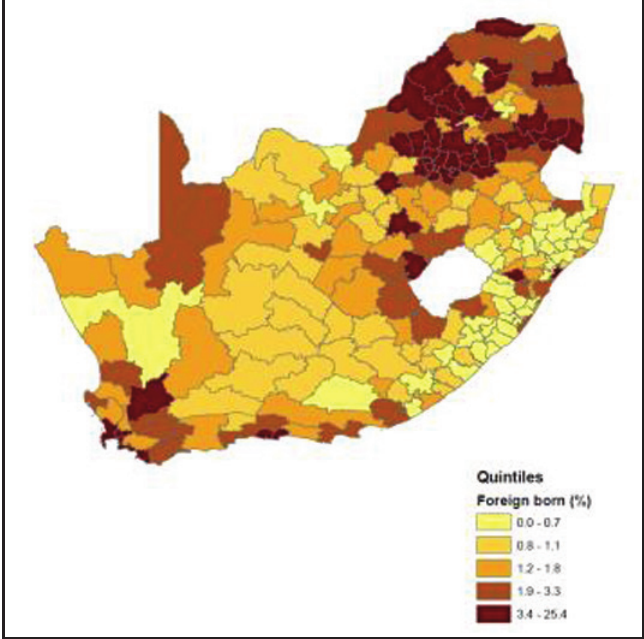
Figure 3 Spatial distribution of immigrants (2011 census